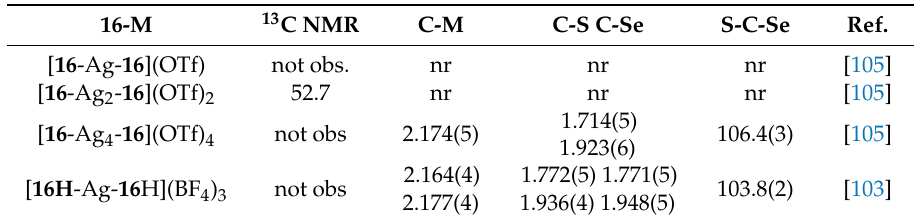
Table 13. Transition metal complexes with selected bond length (Å) and angles (deg) of the carbone 16 . 13 C NMR signal (in ppm) of the central carbon atom.